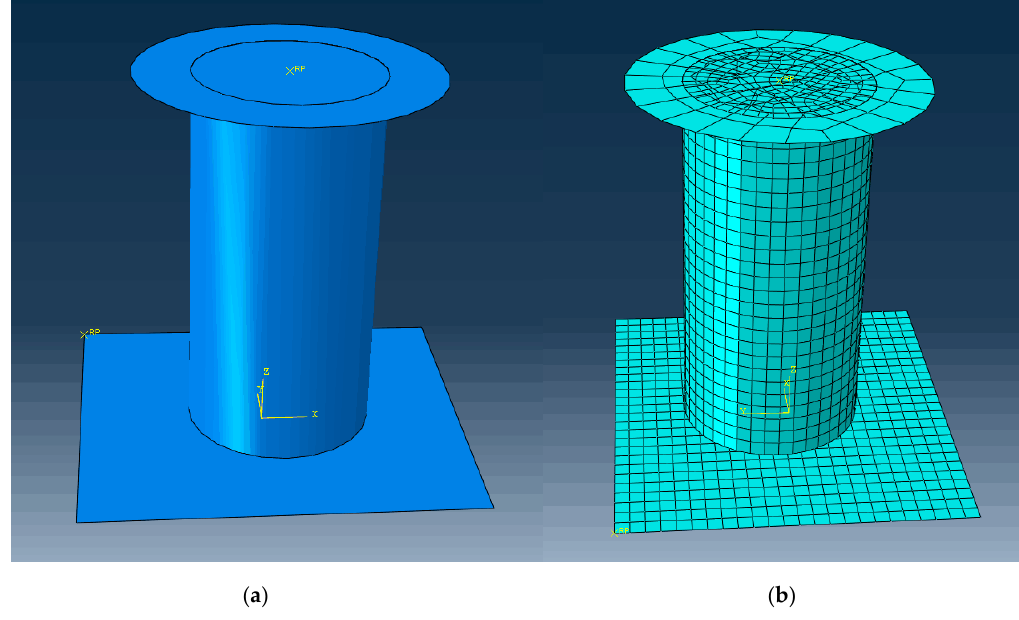
Figure 17. Coupling and meshing: ( a ) coupling graph; ( b ) meshing graph.